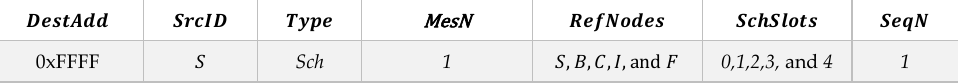
Figure 4. The synchronization process of LPSRS in a single broadcast domain. node, SIR is the specified reference node, and K represents the other neighbor’s nodes of R